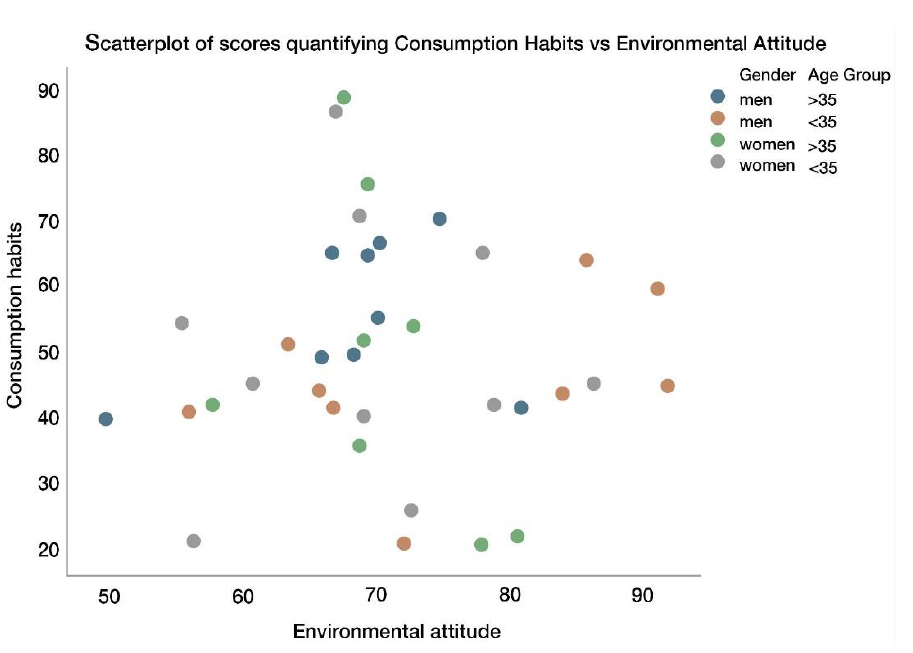
Figure 16. Scatterplot of scores quantifying consumption habits and environmental attitudes. The coefficient of correlation was 0.029, with a 95% confidence interval ( − 0.303–0.354) clearly containing the value of zero. This result is the same when stratifying by gender or age group (with coefficients of correlation always including 0 for a 95% confidence inter- val.). The correlation between consumption habits and the percentage of correct identifi- correlation: ( – 0.016 – 0.58)). The correlation between environmental attitude and the per-